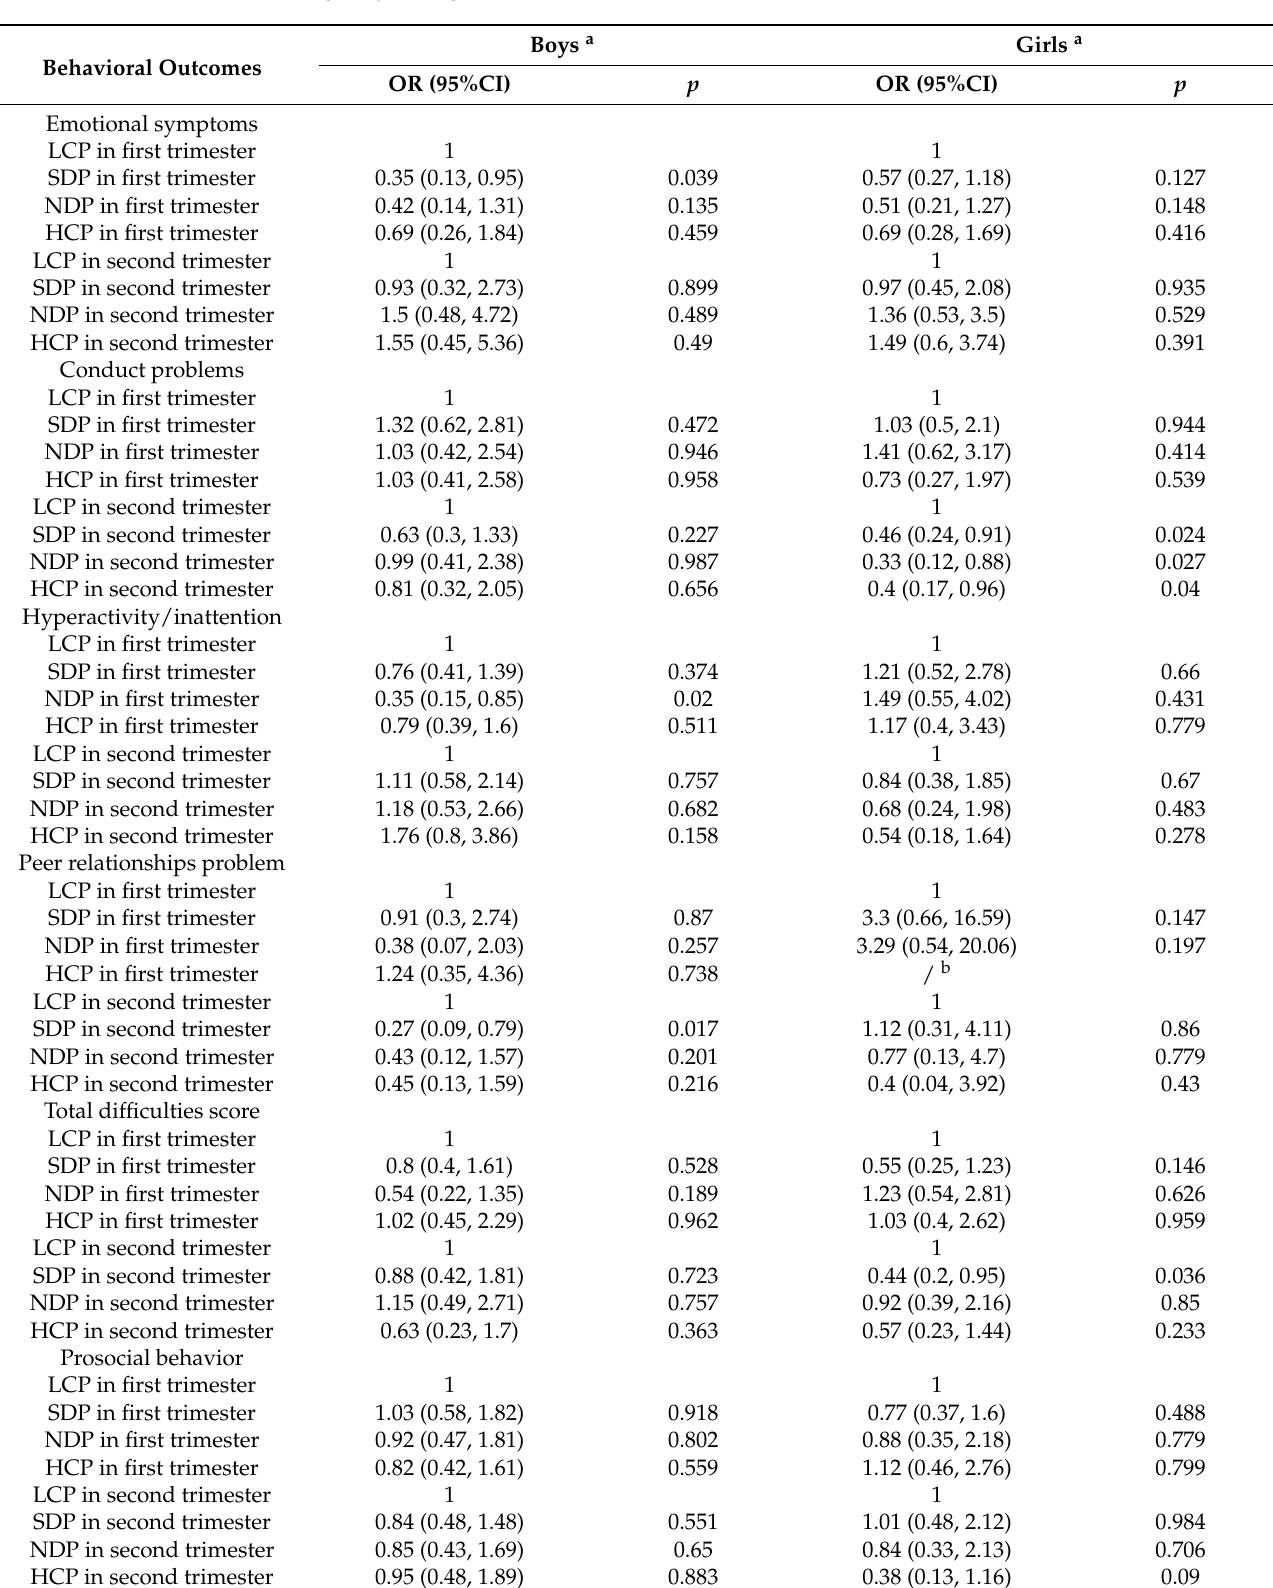
Table 8. Associations of prenatal maternal dietary patterns with the behavioral problems in preschool- age boys and